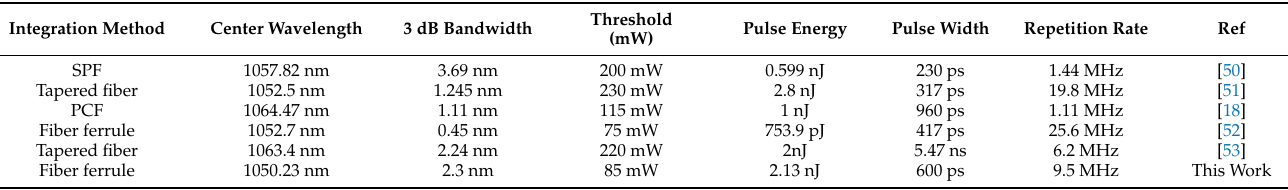
Table 1. Mode-locked YDFL based on Bi 2 Te 3